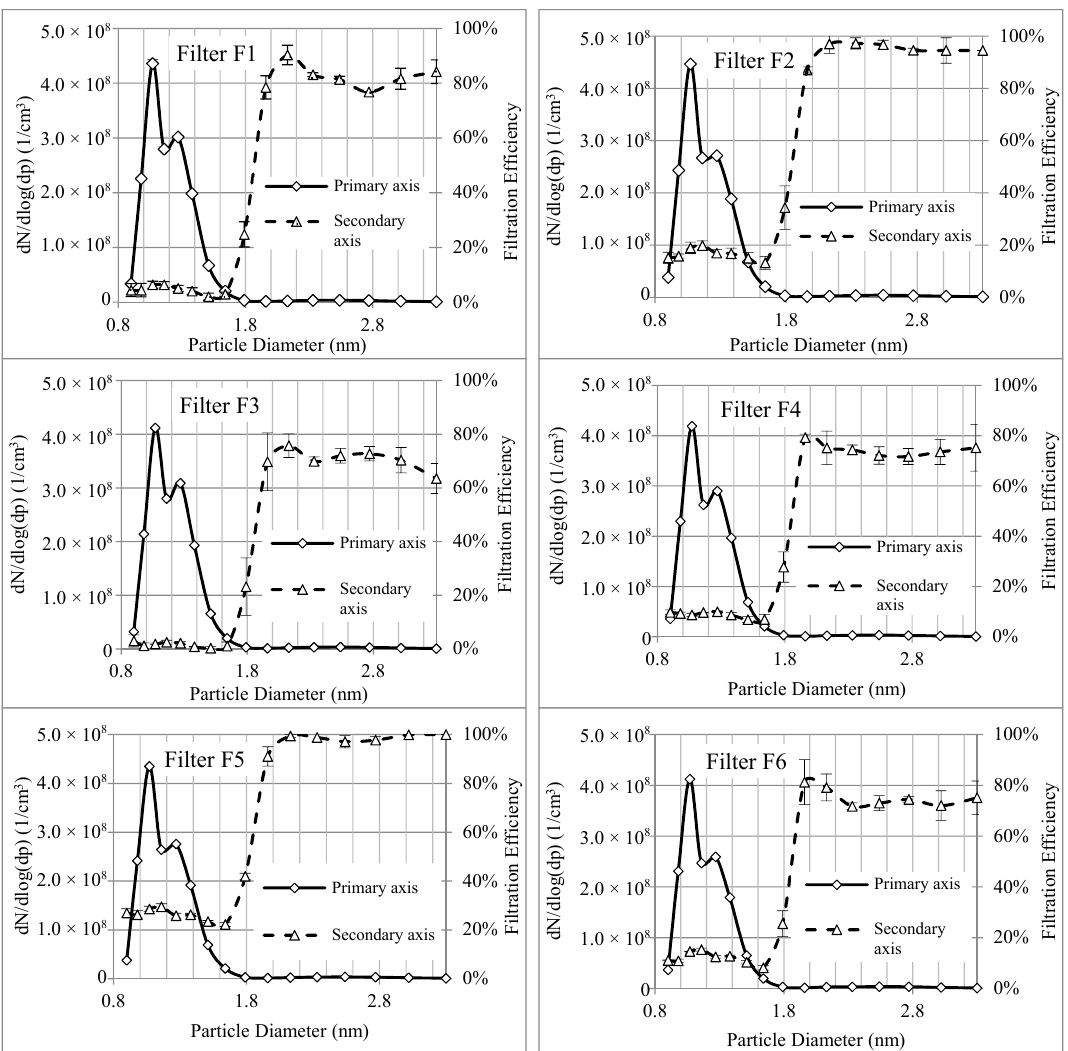
Figure 4. Nanoparticle size distributions along with particle removal efficiencies of different nanofibrous electrospun filters.